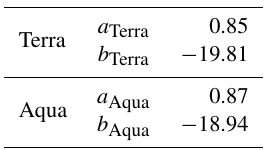
Table 1. Corrected parameterizations of available energy for the di- urnal